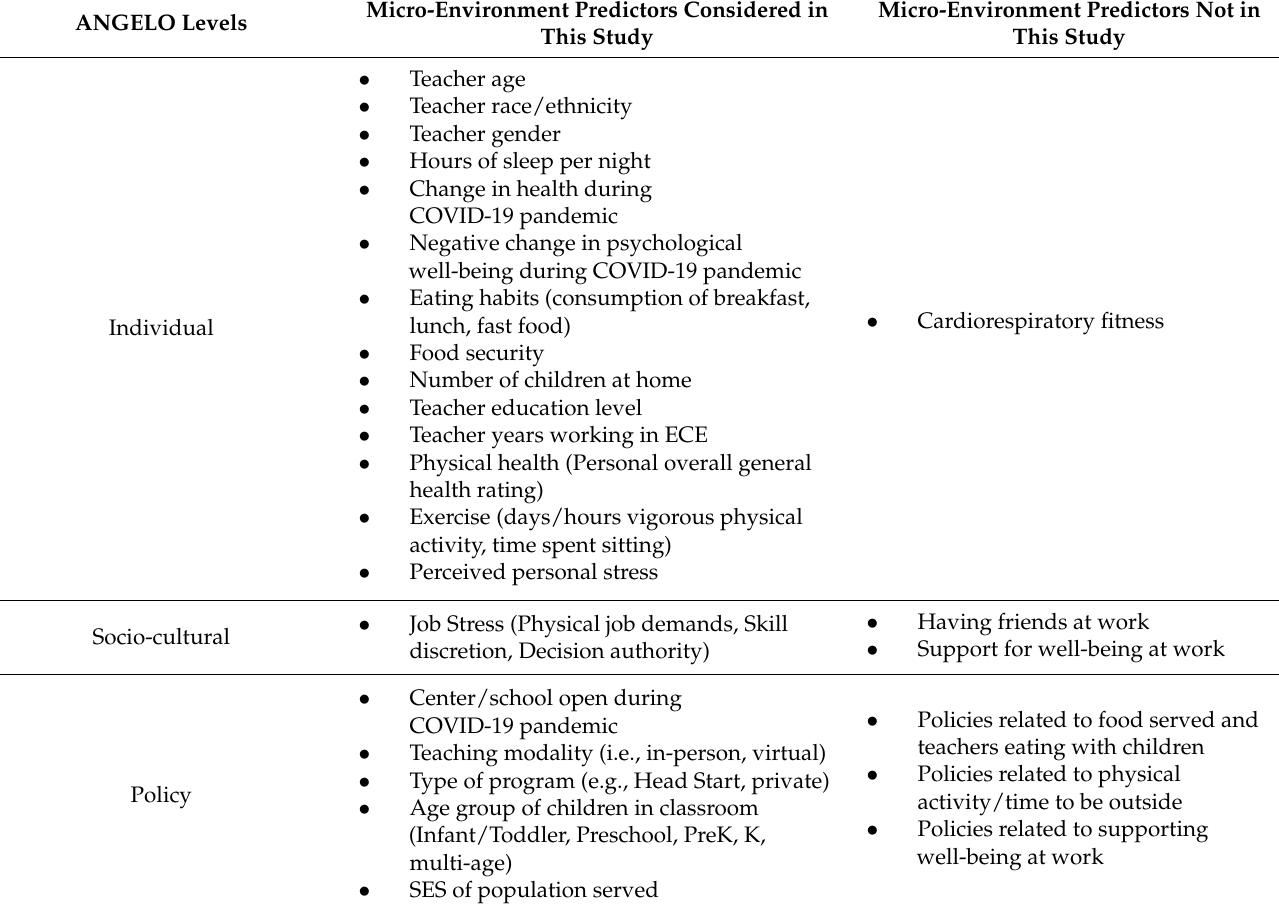
Table 1. Micro-Environment Predictors of Teacher Obesity within the ANGELO